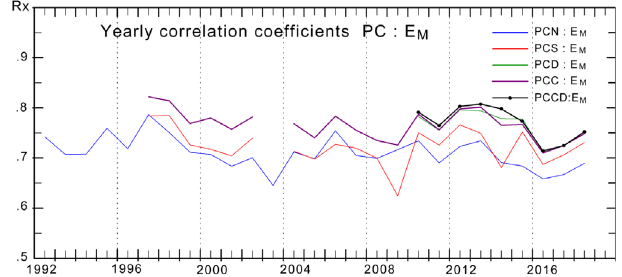
Fig. 5. Yearly averages of correlations between E M and PCN (blue line), PCS-Vostok (red), PCS-Dome-C (green), PCC-(Qaanaaq- Vostok) (heavy magenta), and PCCD-(Qaanaaq-Dome-C) in heavy black line.